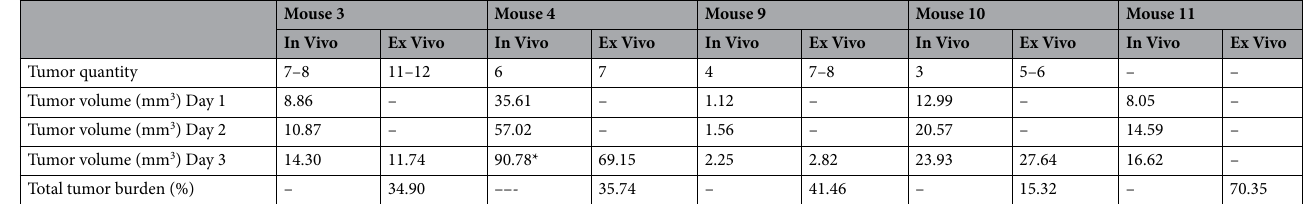
Table 3. Tumor quantity and volume measured from in vivo and ex vivo micro-CT images for the five mice injected with Fenestra HDVC. The quantity was measured by counting individual tumors in the liver. The tumor volume is measured in the in vivo and ex vivo images. The asterisk (*) indicates a large volume change that does not follow the growth pattern of all other tumors